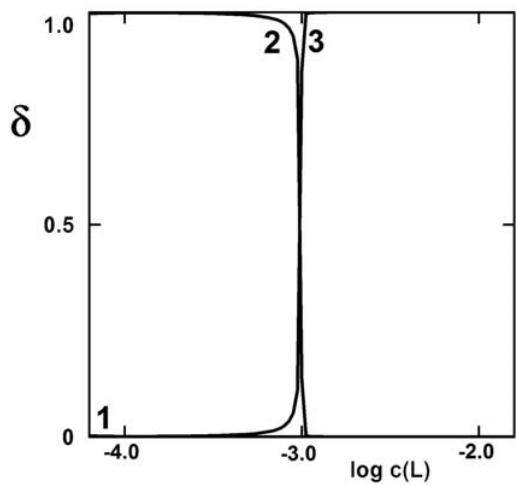
Figure 5. Distribution diagram of americium in the equilibrium ni- trobenzene phase of the water– HNO benzene– N,N,N’,N’ -tetrabutyl-1,10-phenanthroline-2,9-dicarboxa- mide (L)–H + B – extraction system in the forms of Am 3+ , AmL 23+ , and AmL 33+ ; c(HNO 1 δ (Am 3+ ) = [ Am 3+ 3 δ( AmL 33+ ) = [ AmL 3+ [ AmL 3+